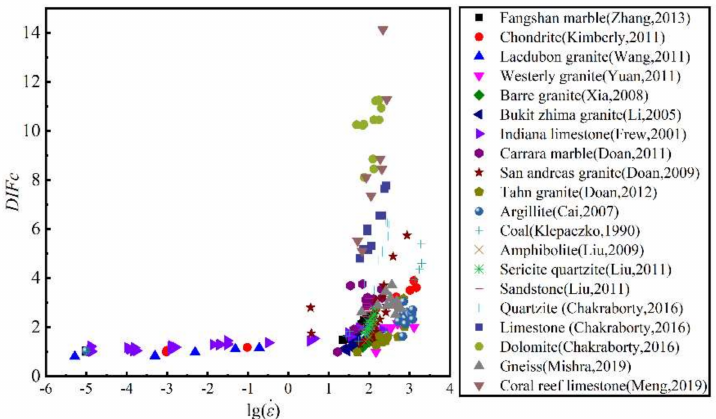
Figure 4. Relationship between DIF and strain rate of different rock under dynamic compression conditions (data from